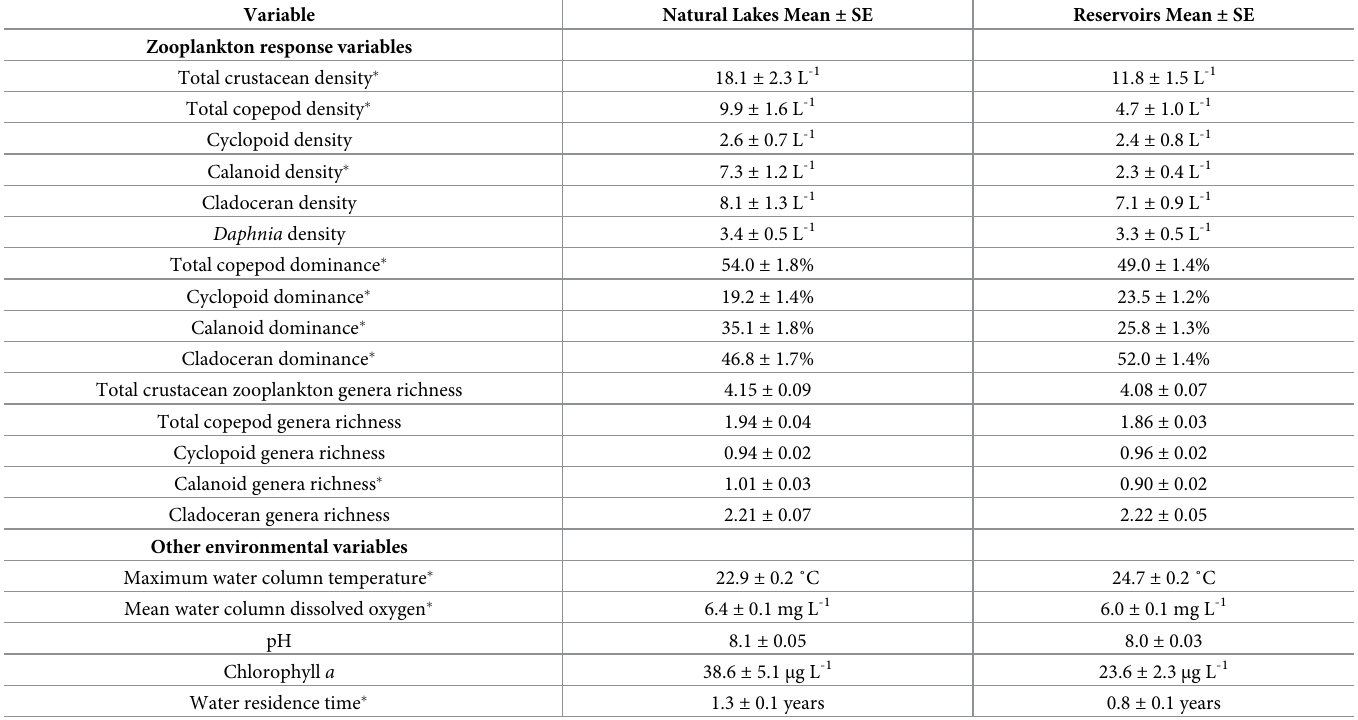
Table 1. Comparison of each zooplankton group and other environmental variables between natural lakes and reservoirs across the continental U.S., with each vari- able’s untransformed mean values and standard errors